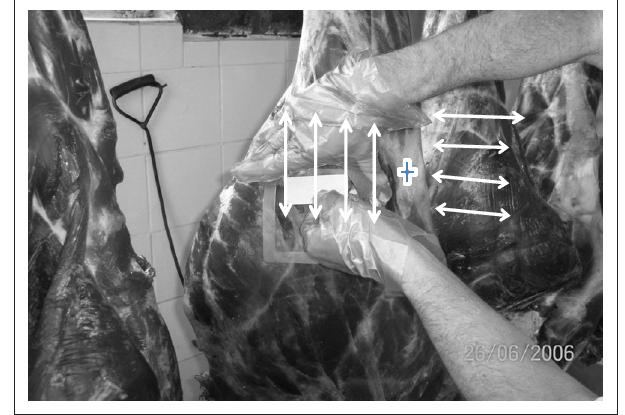
FIGURE 2: The biotrace swabbing